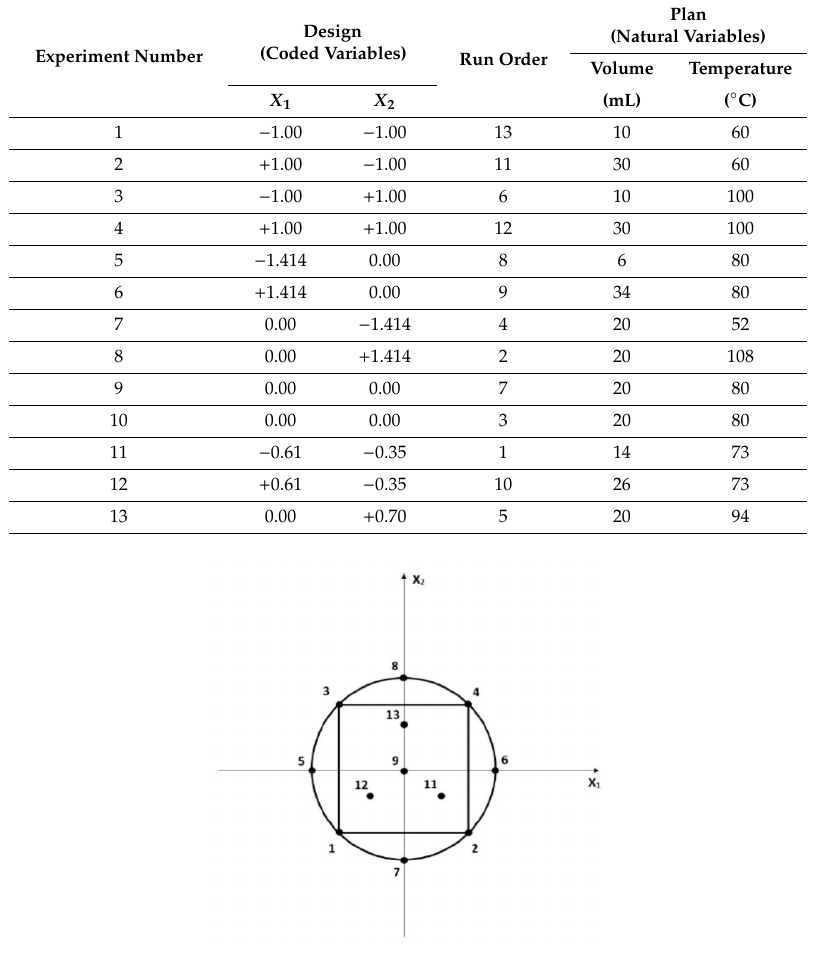
Table 3. The Central Composite Design for spent co ff ee extraction optimization: coded and natural variables under study. Extraction was carried out in water.